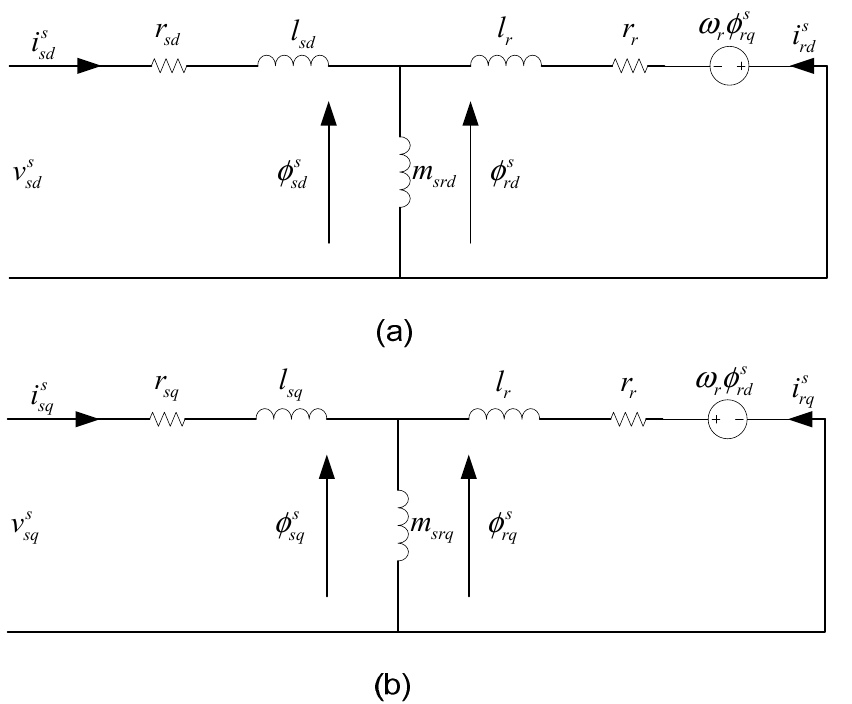
Figure 7. TPIM equivalent circuit in stationary reference frame: ( a ) the d-axis equivalent circuit and ( b ) the q-axis equivalent circuit.